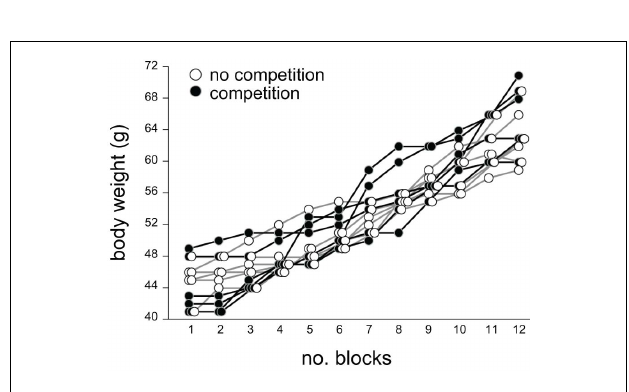
FIGUREA3 | Body weight of individuals in the two groups of chicks in experiment 2 (Figure 2) was plotted against number of blocks. Chicks of both groups similarly grew irrespectively of the training